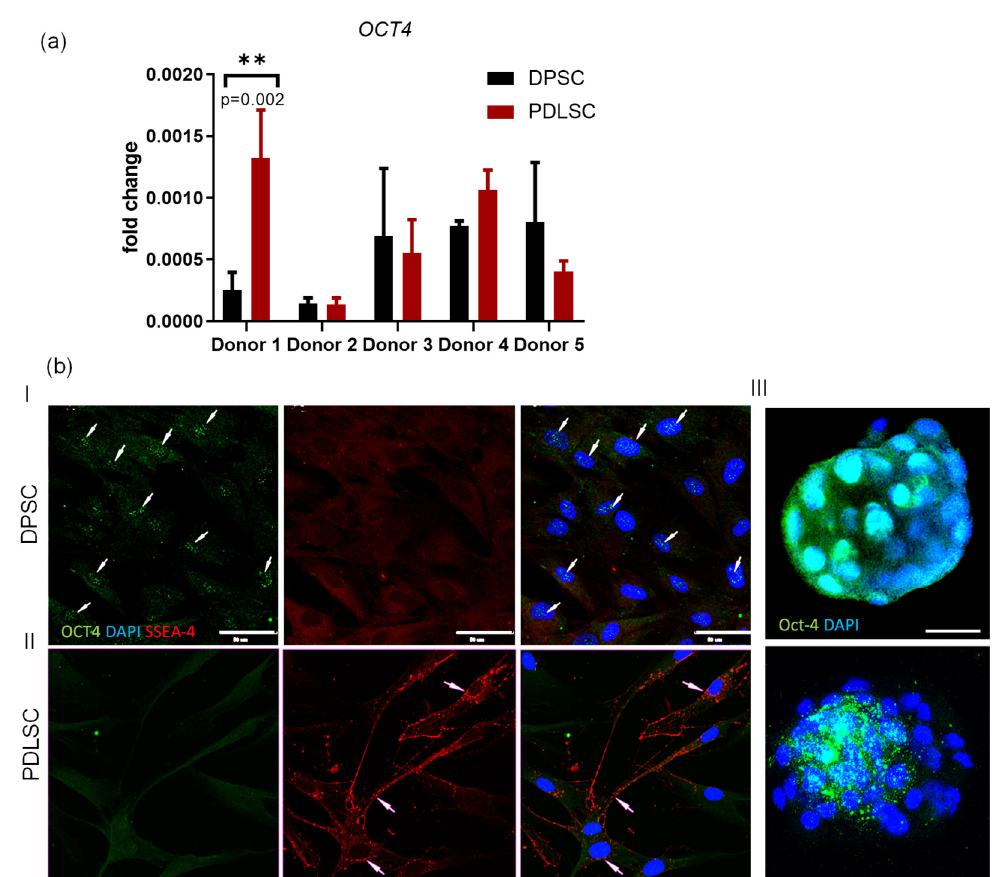
Figure 3. OCT4 and SSEA-4 in DPSC and PDLSC. ( a ) Quantification of OCT4 mRNA by qPCR. References: GAPdH, β -actin, positive control—blastocyst’s total RNA. **— p < 0.01 (the exact p -value is also shown); ( b ) Immunofluorescent staining of DPSC (panel I), PDLSC (panel II) with the ABs against OCT4 (green) and SSEA-4 (red). Panel III—a morula (upper image) and a blastocyst (bottom image) stained with the AB against OCT4. According to the previously published data, these two stages are positively stained for OCT4 [38] and were therefore taken as a positive control in our study. Nuclei are counterstained with DAPI (blue). White arrows–positive staining with the AB. Scale bars (50 mkm) are shown in the images.